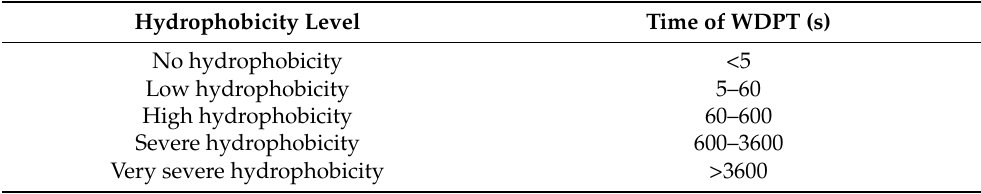
Table 1. Soil hydrophobicity level based on the WDPT (water droplet infiltration time test)